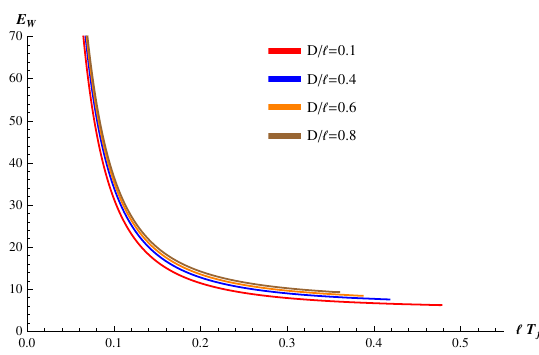
Figure 4. Variation of E W with respect to the dimensionless quantity lT f for different values of D/l , indicating the decreasing behavior of EWCS as the effective temperature increases (with l =